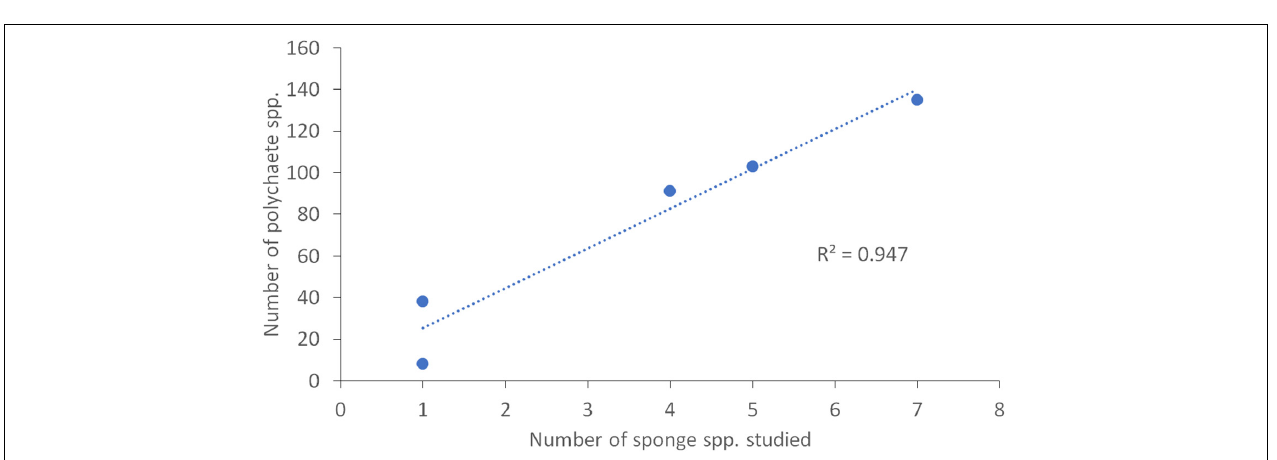
FIGURE 3 | The number of polychaete species reported from sponges in the Mediterranean Sea and the number of studies considered in this research.